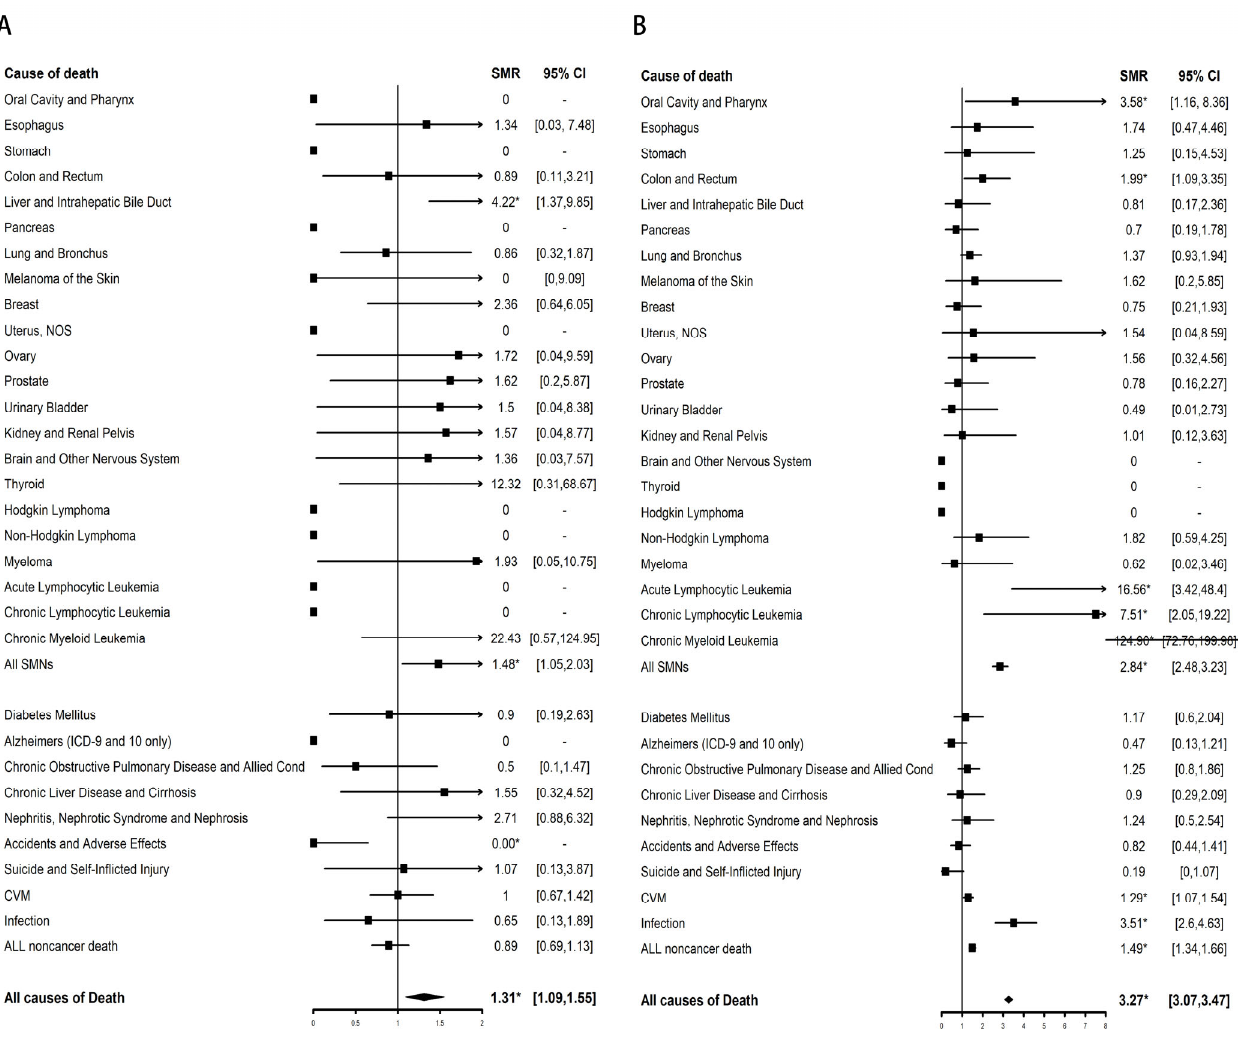
Figure 2. SMRs of site ‐ specific death among >5 ‐ year survivors of APL ( A ) and non ‐ APL AML ( B ) compared with the general population. The solid vertical lines represent the SMR of 1.0. The horizontal lines represent 95% confidence intervals for the SMRs. The box represents the result of SMR. The diamond at the bottom shows the summary SMR of all the combined individual studies. We used the Poisson exact method for SMR to compute the 95% CI and corresponding p values, and the 95% CIs not including 1 with p < 0.05 were defined as significant differences for SMR. * p < 0.05 The risk of dying from AML (SMR, 292.93; 95% CI, 265.26–322.7) and SMNs (SMR, 2.84; 95% CI, 2.48–3.23) in >5 ‐ year survivors of non ‐ APL AML was significantly higher